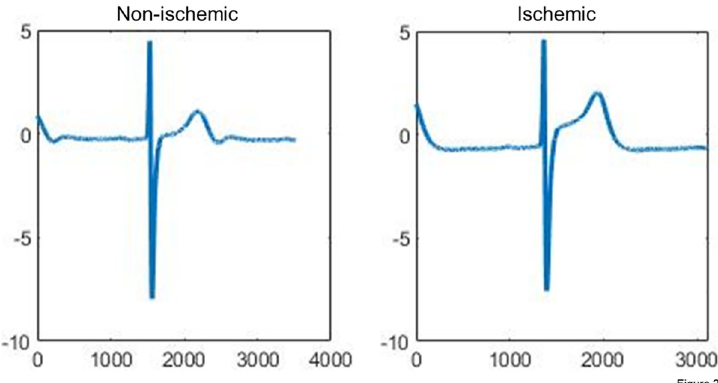
Fig 2. Input data for the neural networks. The input data were taken from the original study analysis and converted into jpgs with a predefined image size (224x224x3 pixels). Each image contained either the illustration of a non– ischemic (i.e., recorded directly before the coronary balloon occlusion) or an ischemic (i.e., recorded at the end of the balloon occlusion) intracoronary ECG as well as the corresponding label (non–ischemic respectively ischemic). In this example, both icECGs are from the same vessel (left anterior descending coronary artery) from the same patient. IcECG ST–segment shift was 0.056mV respectively 0.858mV.